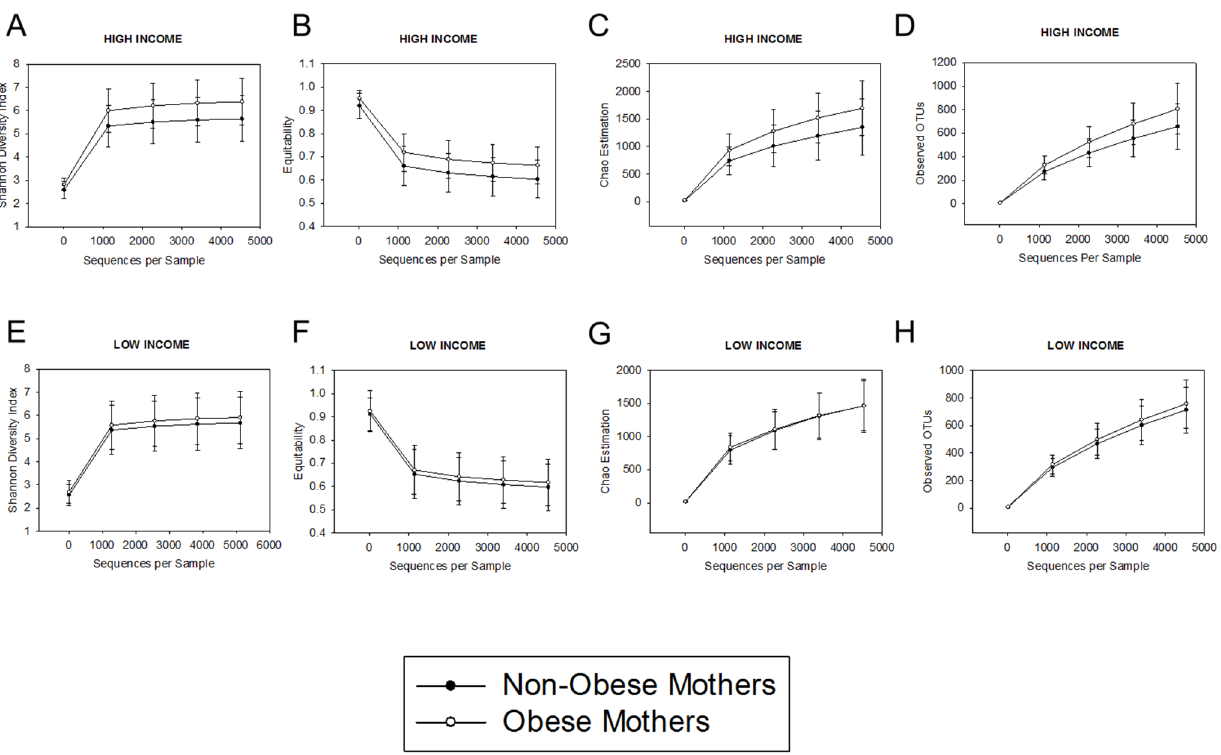
Figure 4. As with measures of beta diversity, differences in alpha diversity in relation to maternal obesity were seen predominately in the higher SES group. In the higher-income group, children born to obese versus non-obese mothers had significantly higher A) Shannon Diversity Index, B) equitability, C) Chao1 estimation, and D) observed operational taxonomic units (OTUs) ( p s # 0.05). In contrast, in the lower-income group, no significant effects of maternal obesity on alpha diversity indicators were observed (E–H).